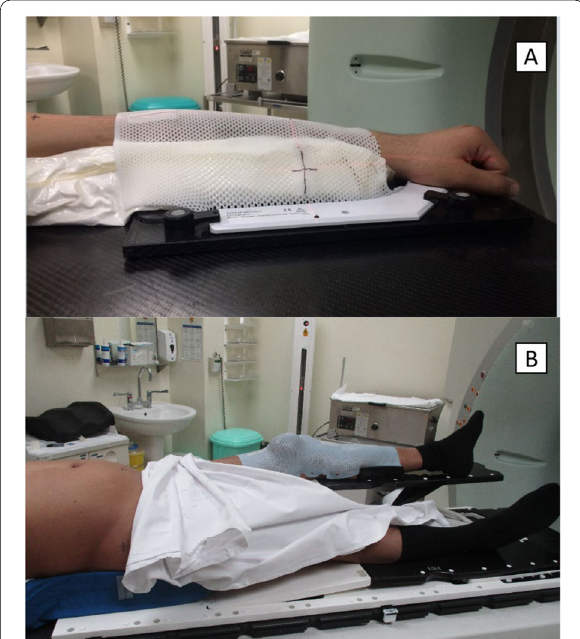
Fig. 2 Patients with thermoplastic cast immobilization device. The figure showed thermoplastic cast immobilization device for 2 patients ( A patient with upper extremity soft tissue sarcoma and B patient with lower extremity soft tissue sarcoma) with landmarks on the patient and the